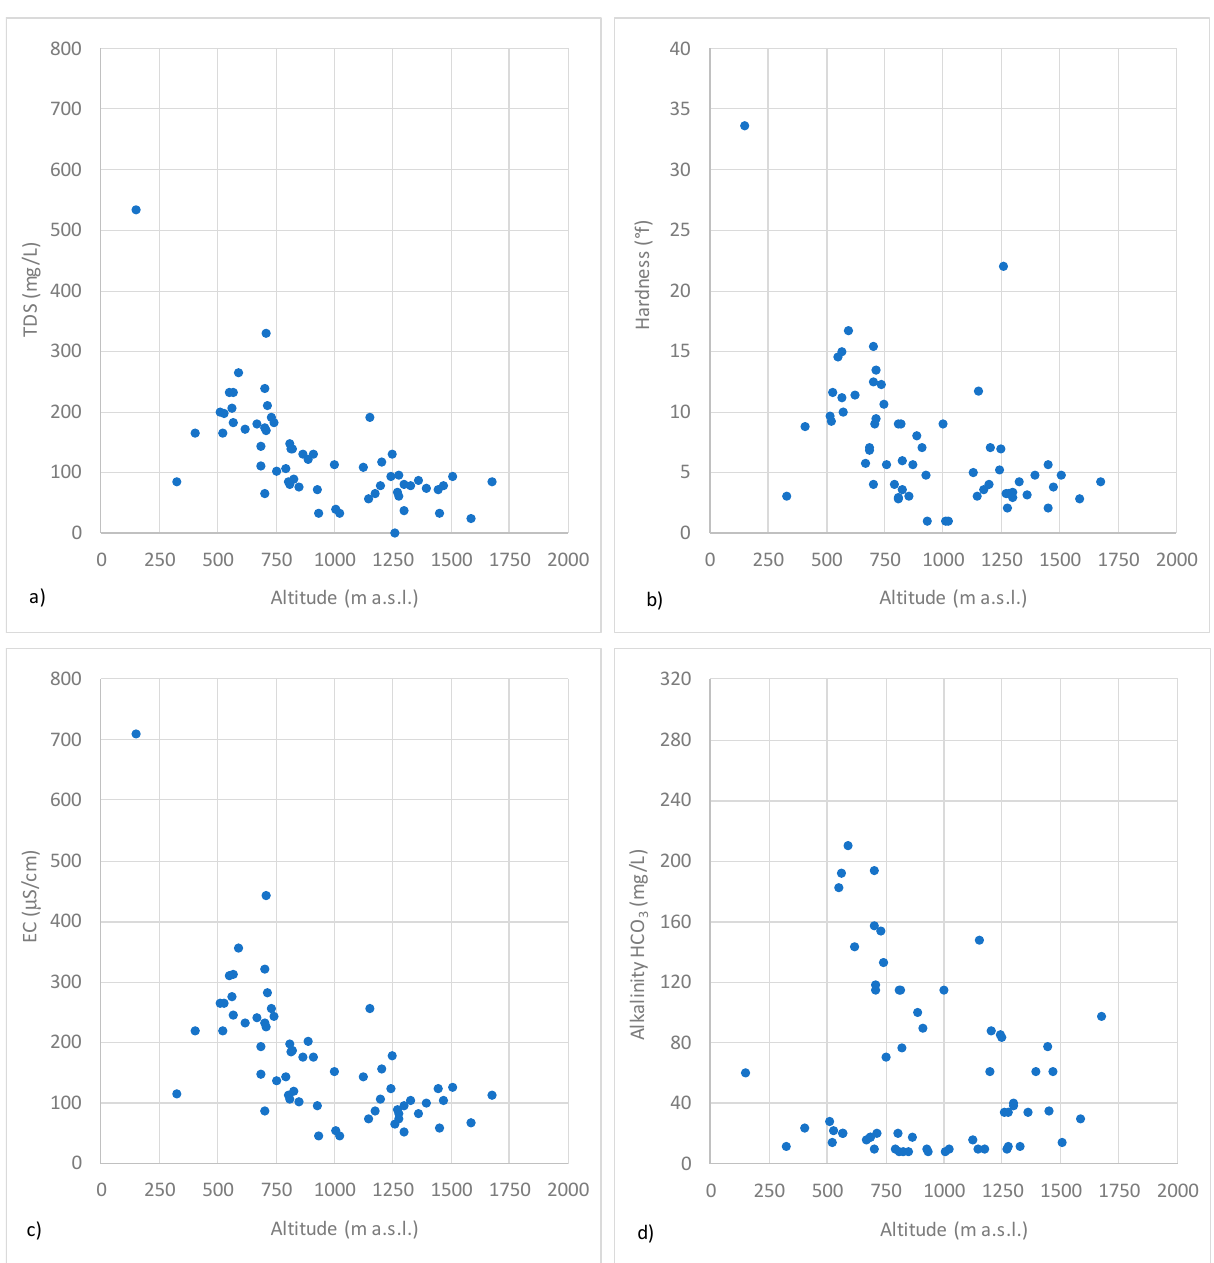
Figure 2. Bivariate plots of TDS ( a ), H ( b ), EC ( c ) and A ( d ) vs. altitude. According to the results of the aggressiveness index I A , it was possible to classify 78% of the analyzed springs as aggressive (I A < 10) and the remaining 22% as moderately aggressive (10 < I A < 12), the latter having a higher conductivity than the former. Figure 3 shows the I A classification of the spring